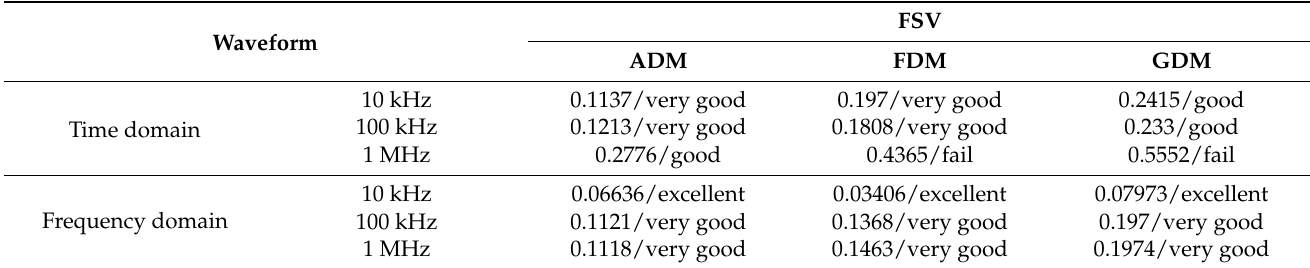
Table 5. The FSV evaluation results of the proposed